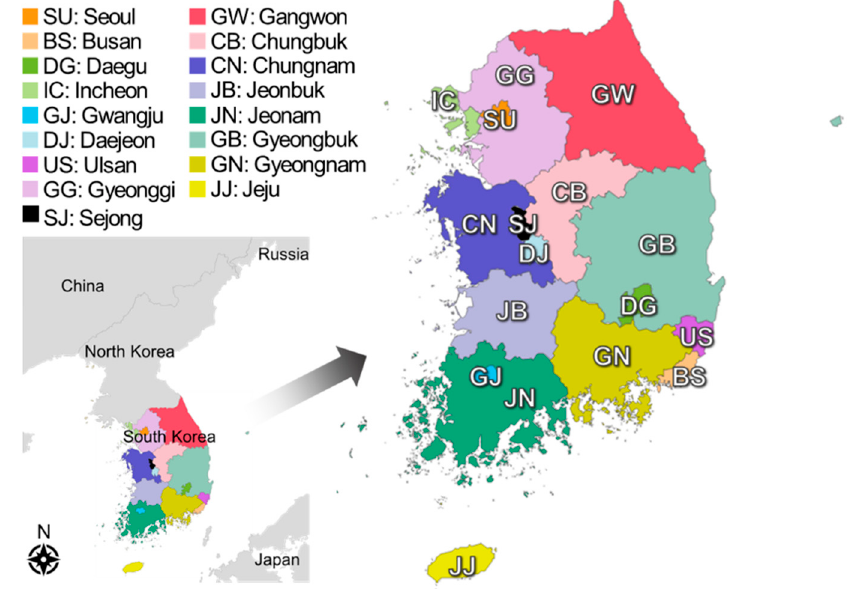
Figure 1. Administration divisions in Korea [37].